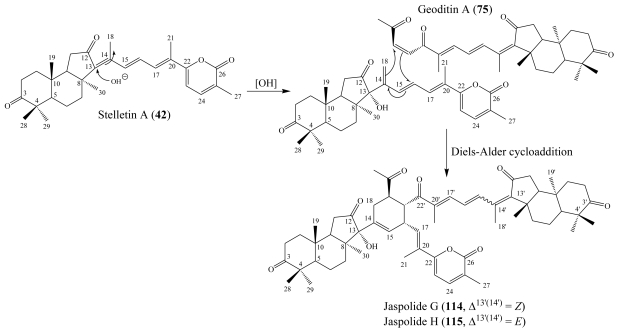
Postulated biogenetic pathway of jaspolides G (114) and H (115) [102].